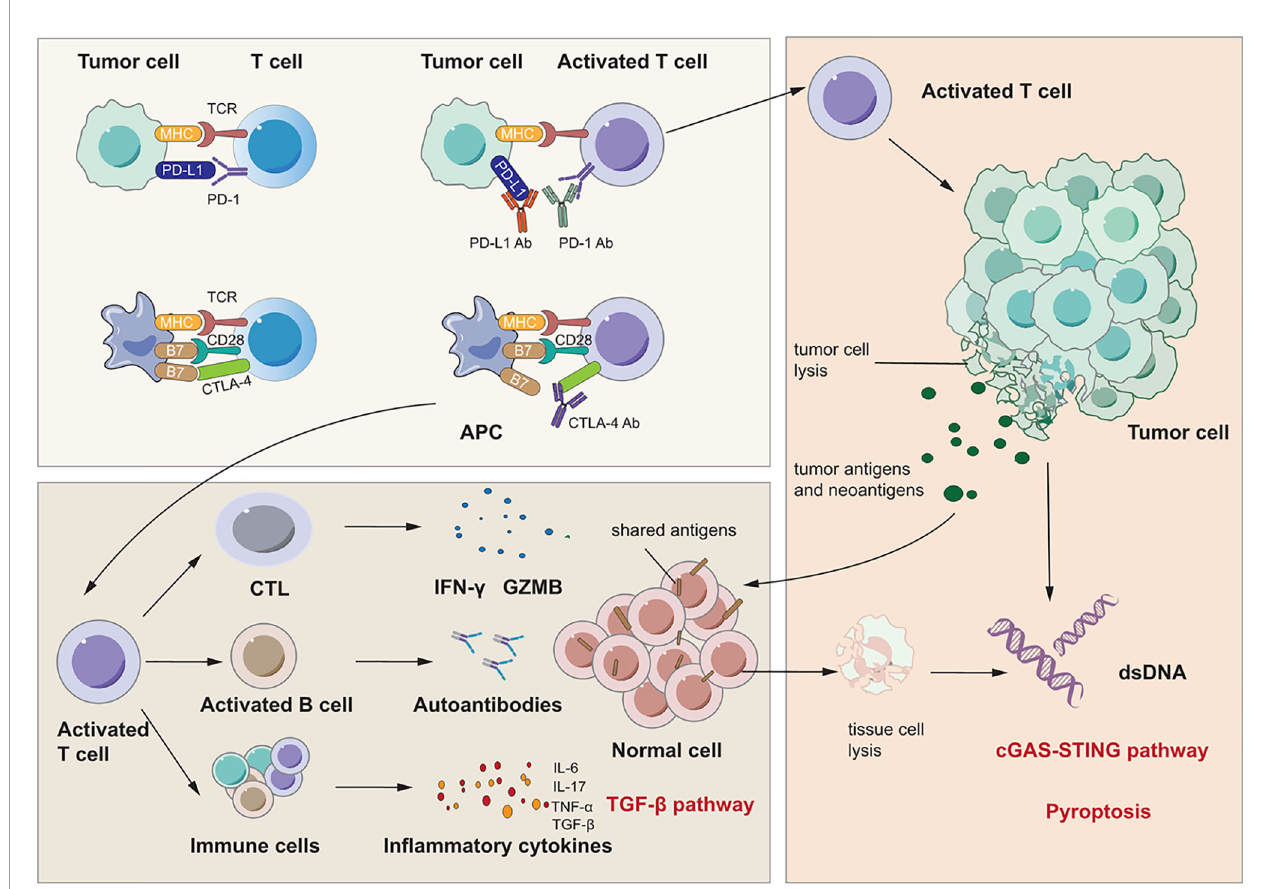
FIGURE 2 | Signaling pathways for immunotherapy-related lung injury. Immune checkpoint inhibitors like PD-1 Ab, PD-L1 Ab and CTLA-4 Ab can bind to PD-1, PD-L1 and CTLA-4 speci fi cally. This can activate immune cells like T cell and CTL to release many cytokines such as IFN- g and IL-17 which can cause lung in fl ammation. At the same time, activated CTL can cause tumor cell lysis which releases tumor antigens and neoantigens. There are shared antigens in normal cells which can be recognized by T cells inducing tissue damage and in fl ammation. Besides, there are pre-existing antibodies in microenvironment with unlclear mechanisms which is related to